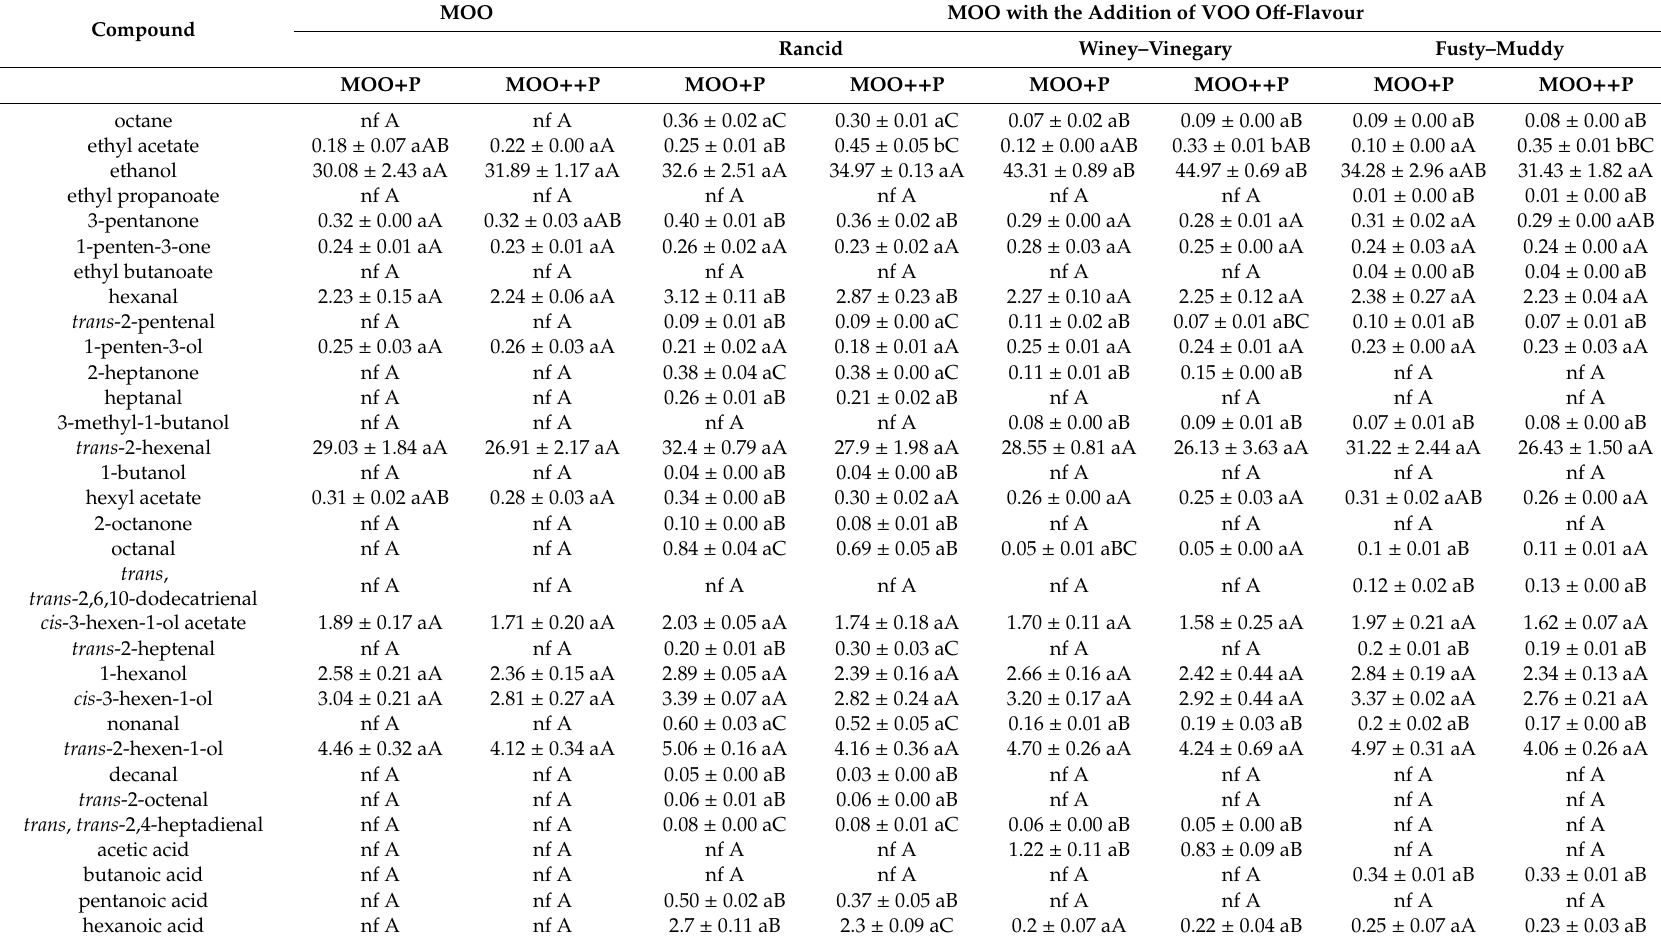
Table 2. Volatile compounds, expressed as mg kg − 1 ± standard deviation, in MOO samples without and with the addition of EVOO o ff -flavours at two di ff erent concentrations of EVOO phenolic